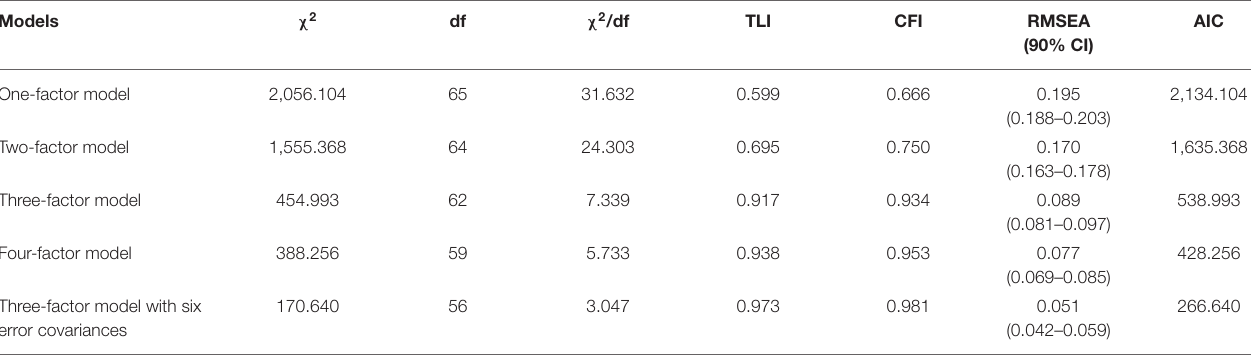
TABLE 3 | Candidate models of the structure of H-UMICS (relational identity); results of CFAs.